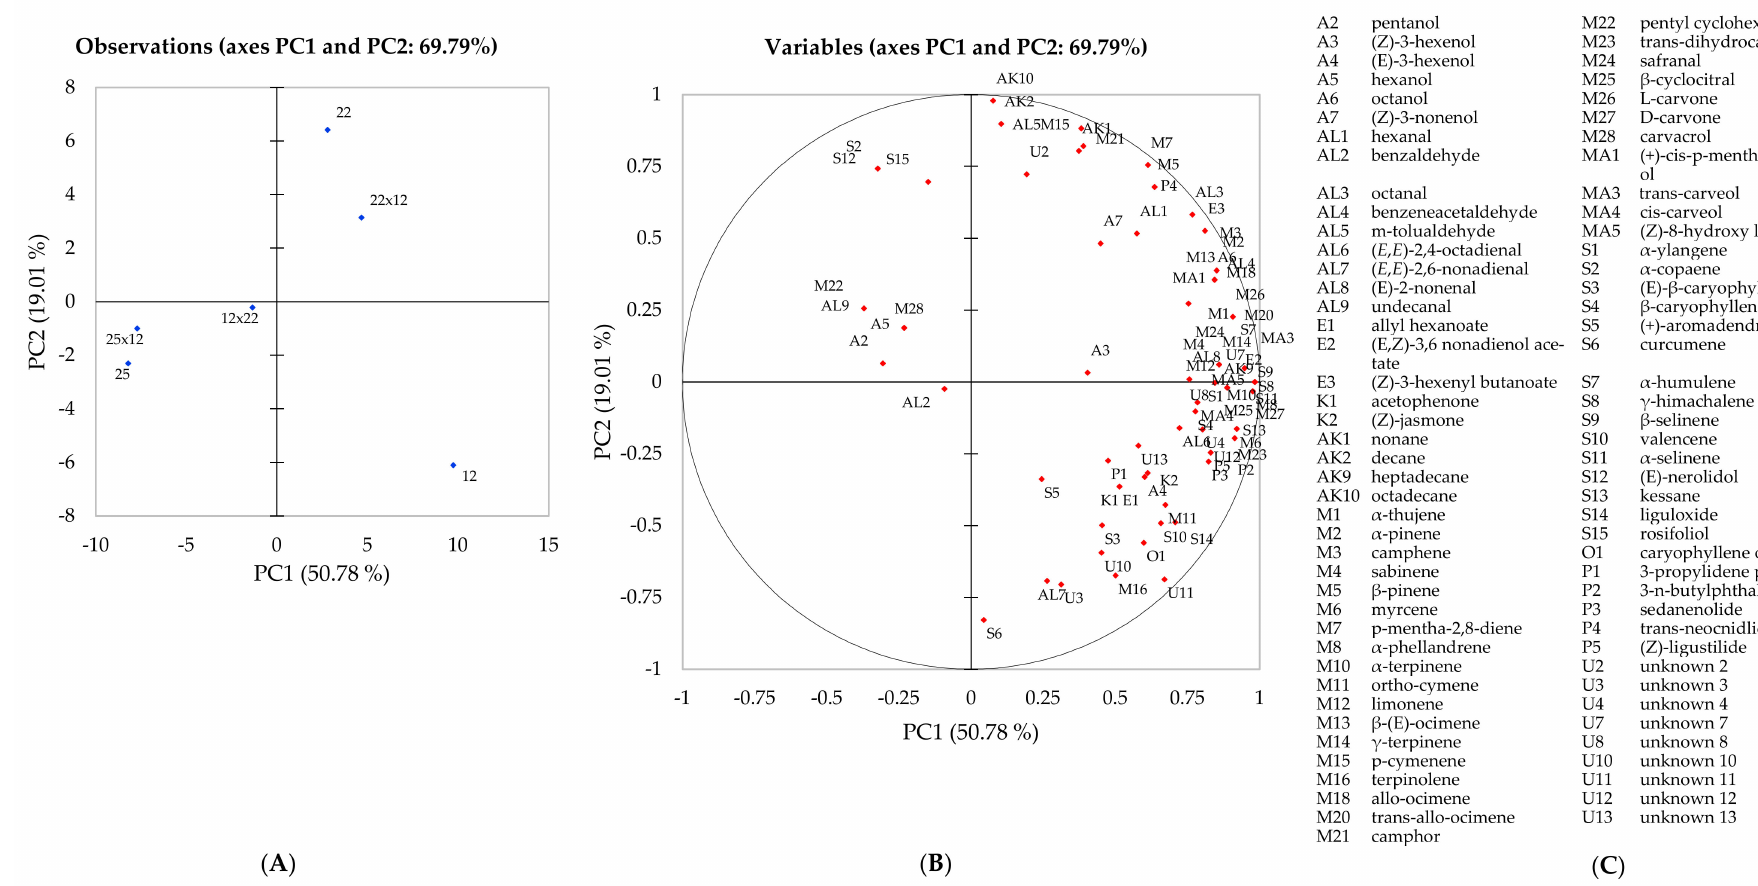
Figure 1. Principal component analysis of six celery samples showing correlations with volatile compounds: ( A ) projection of the samples; ( B ) distribution of variables; ( C ) compound codes as appear in plot ( B